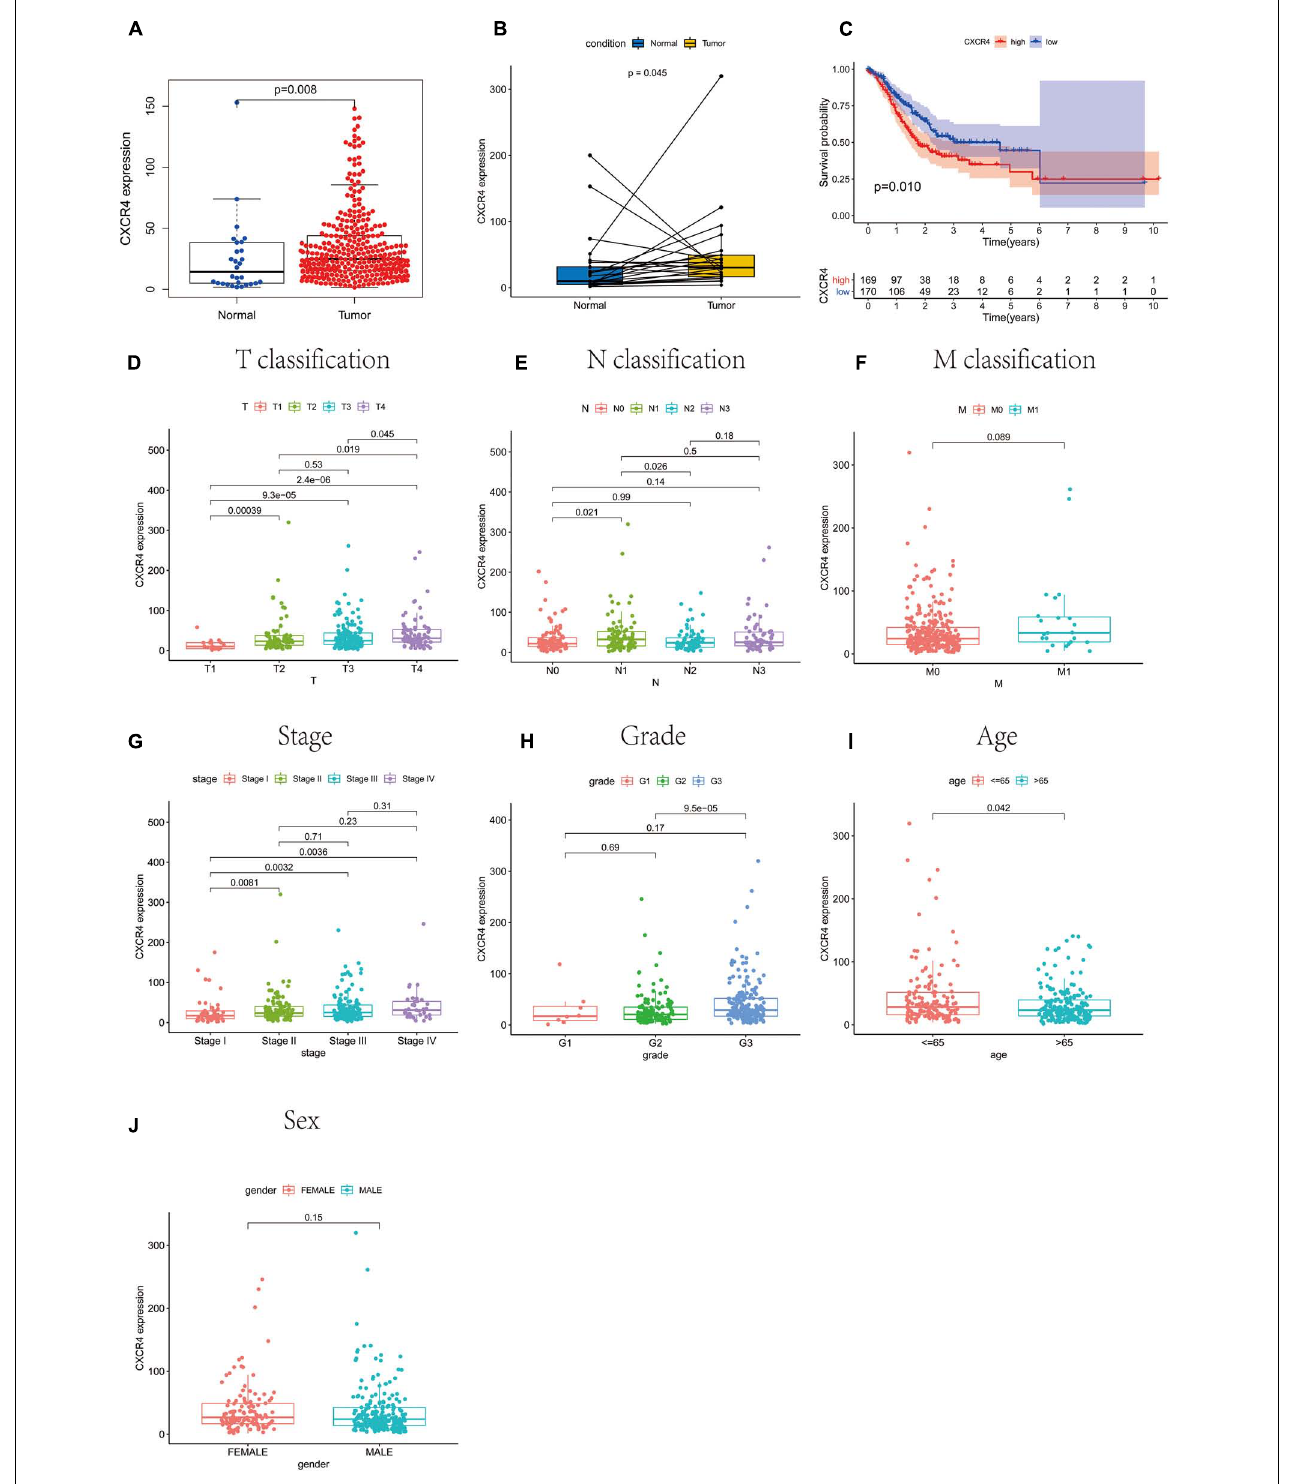
FIGURE 6 | The relationship between CXCR4 expression with survival rate, clinical and pathological characteristics of patients with gastric cancer. (A) unpaired samples, (B) paired samples, (C) survival rate, (D) T classification, (E) N classification, (F) M classification, (G) stage, (H) grade, (I) age, and (J) sex.